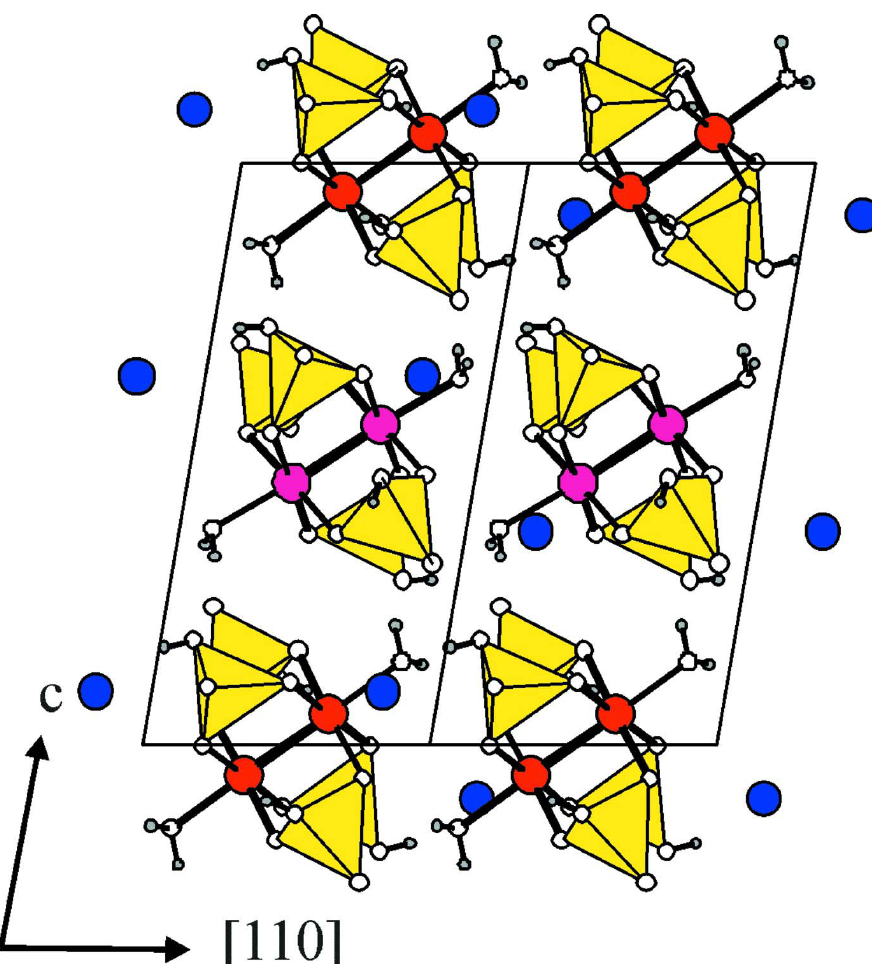
Figure 2 Projection of the crystal strucure of K H+ (blue), O 2- (white) (Progr. ATOMS